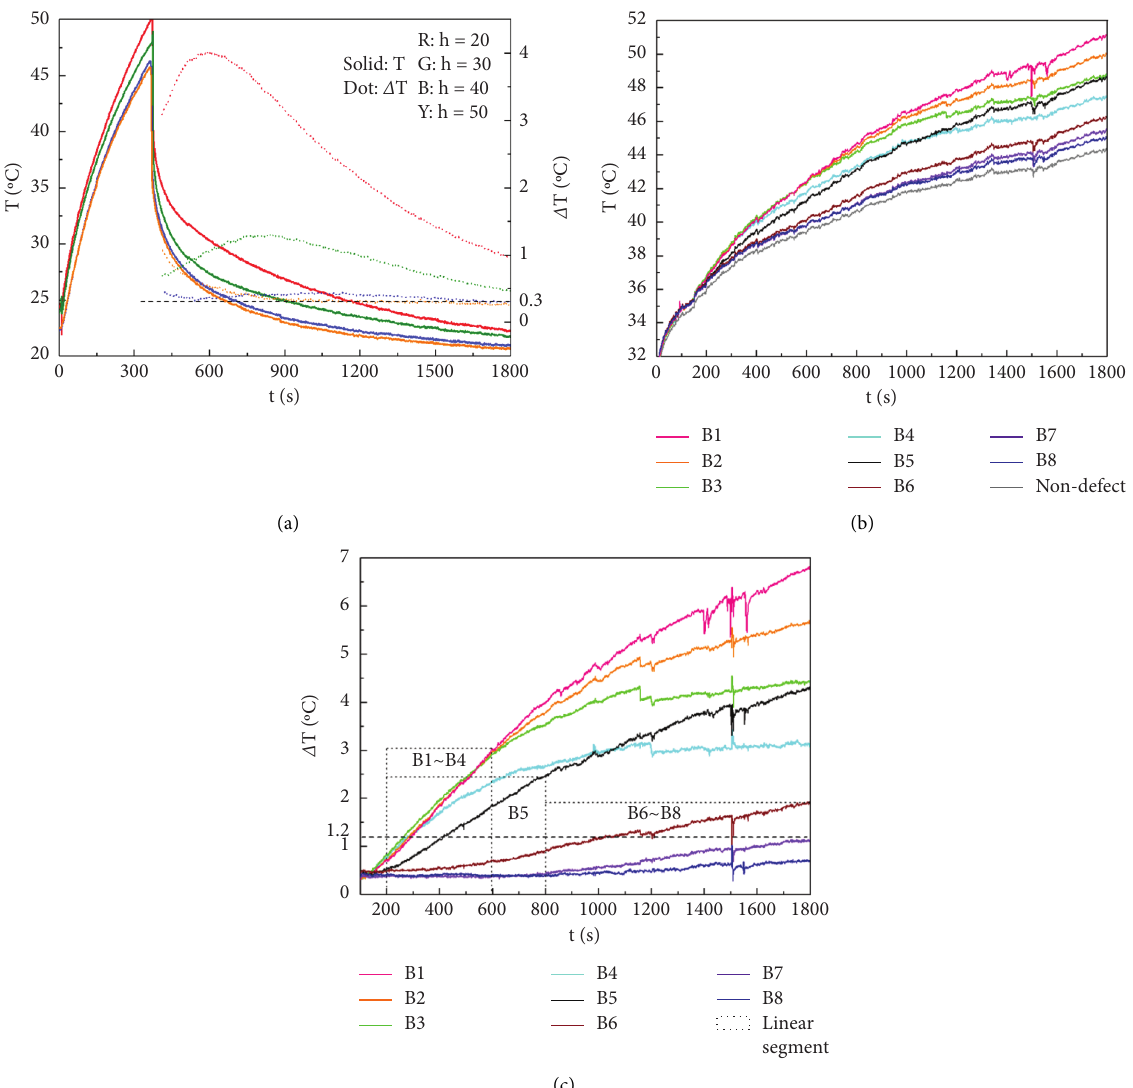
Figure 4: Temperature and temperature difference curve. (a) Pulse heating-T, Δ T ; (b) solar heating-T; (c) solar heating- Δ T .